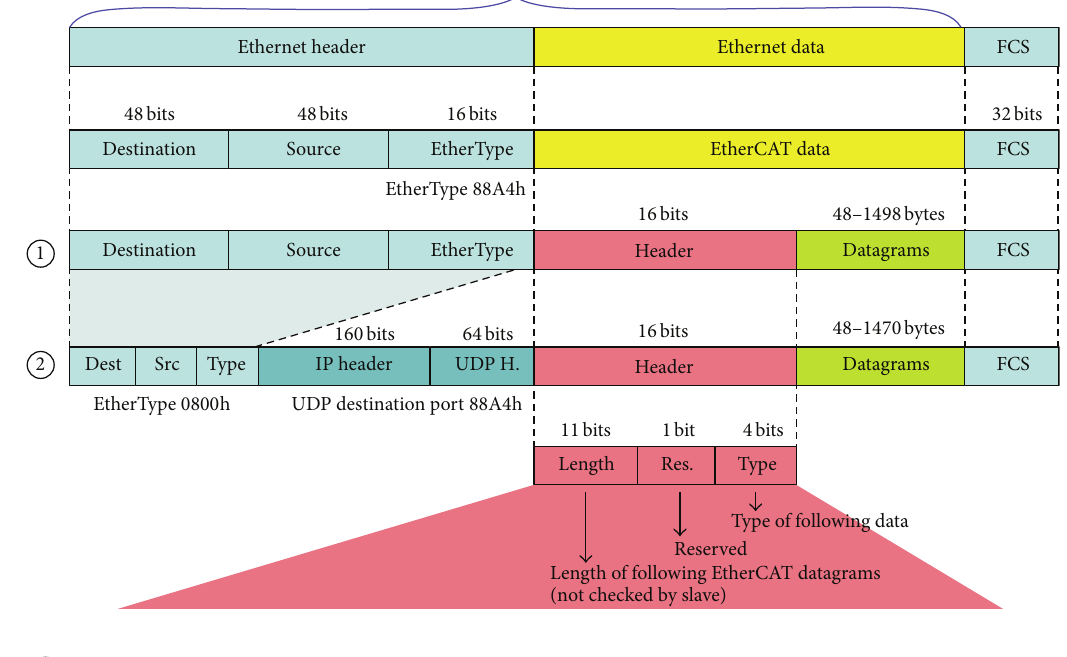
Figure 2: EtherCAT frame structure (slide 28 of [7]).